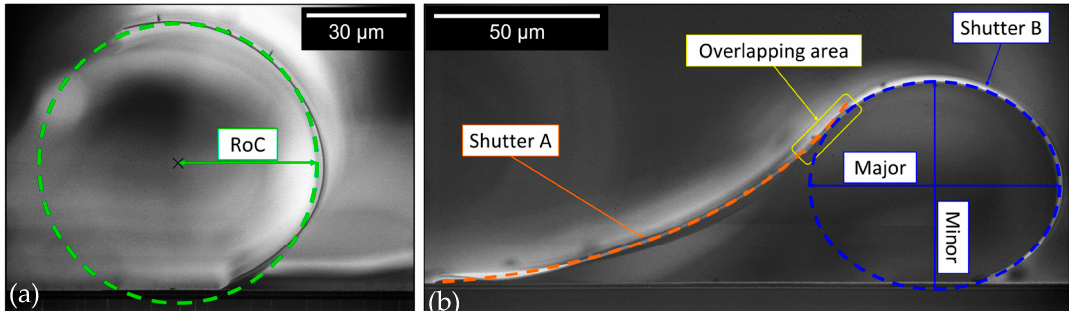
Figure 5. Cross-section SEM micrographs of unpaired and paired micro-shutters with illustrations depciting the conducted analysis: ( a ) unpaired shutter blades with a fitted green circle to identify the radius of curvature (RoC), ( b ) the pairing and the overlapping area between the shutter blades, A and B, and the fitted orange and blue ellipses to idenfity both of the shutter blades. The extracted fit parameters are the major and minor axes.